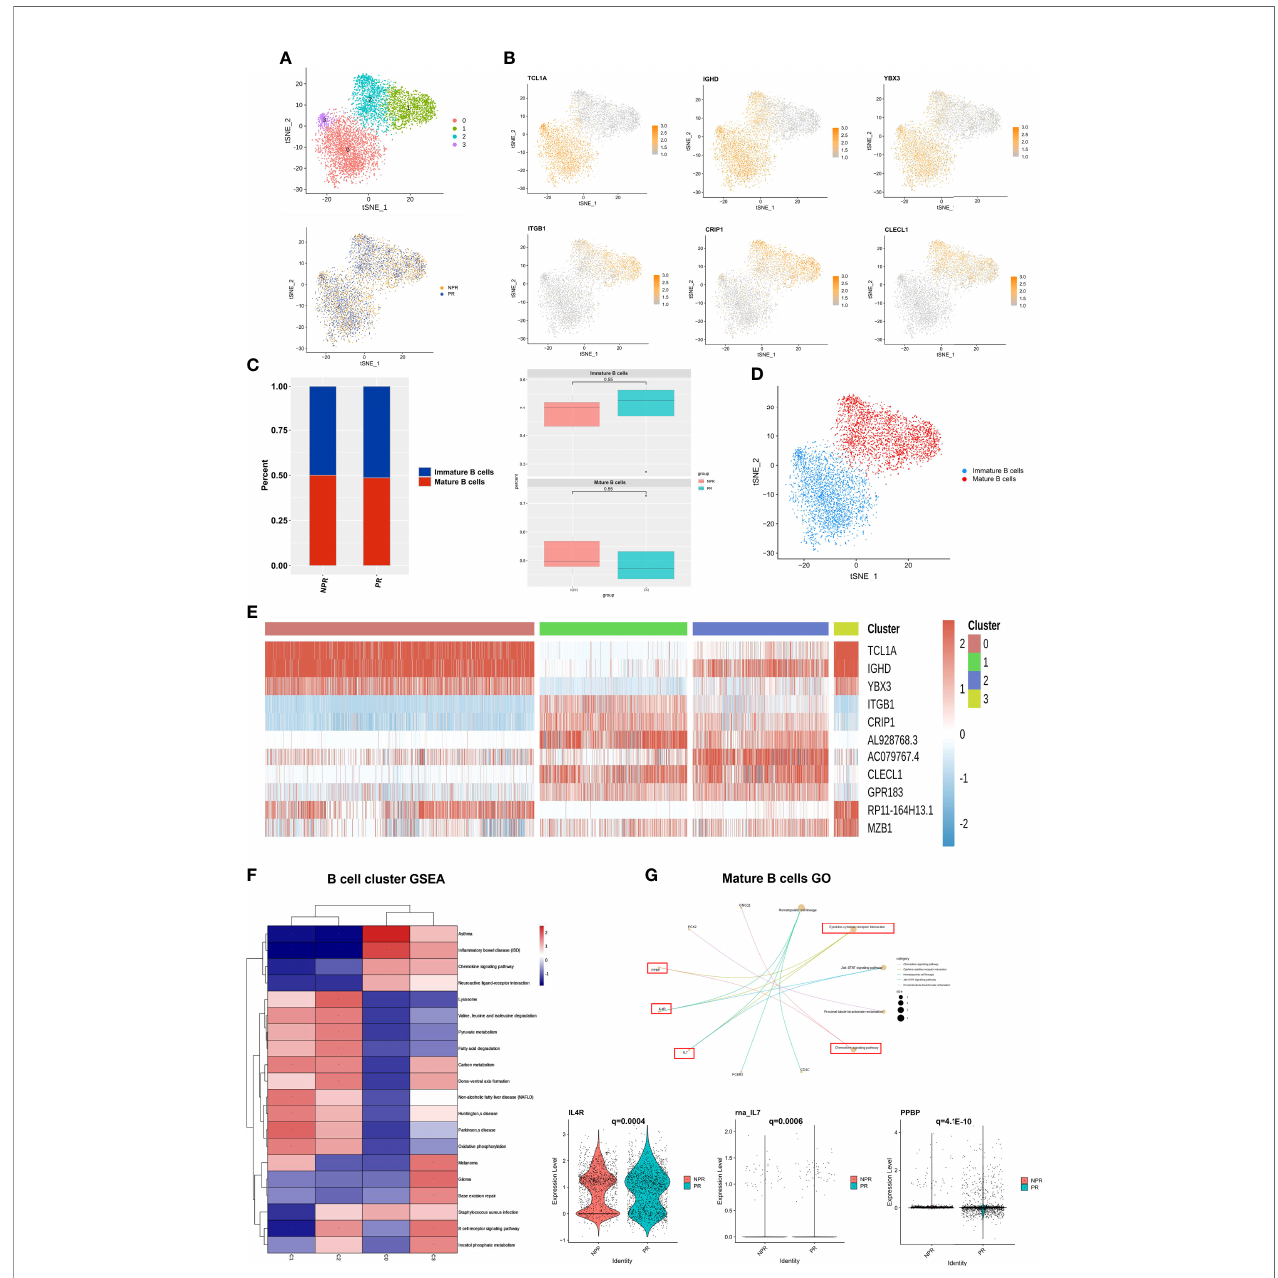
FIGURE 7 | B cells play an important role in producing in fl ammatory cytokines. (A) t-SNE plot showing re-clustering of B cells into 4 clusters and t-SNE plot of patients with PR and NPR. (B) Expression t-SNE plots of B cell marker genes as TCL1A, IGHD, YBX3, ITGB1, CRIP1, and CLEC1. (C) Percent of B cell subtypes in patients with PR and NPR. (D) t-SNE plot showing the contribution of different B cell subsets. (E) Heatmap showing expression levels of discriminative genes for each cluster. (F) GSEA heatmap of B cell clusters. (G) GO analysis of mature B cells and IL4R, IL7, and PPBP were signi fi cant upregulated in patients with